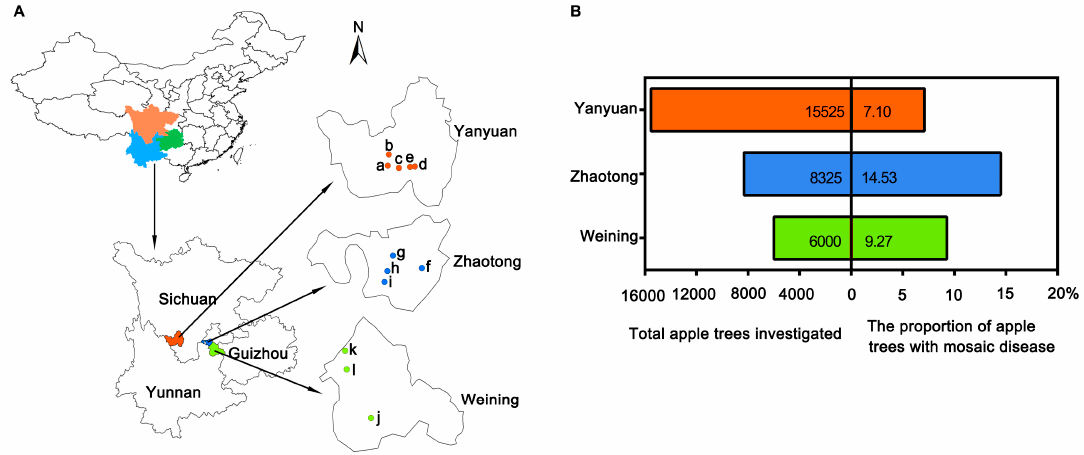
Figure 1. Investigation of apple mosaic disease in southwest China. ( A ) Investigated places in southwest China. Three main apple producing areas in southwest China were shown with different colors, respectively. ( B ) Total apple trees investigated and the proportion of apple trees with mosaic disease.